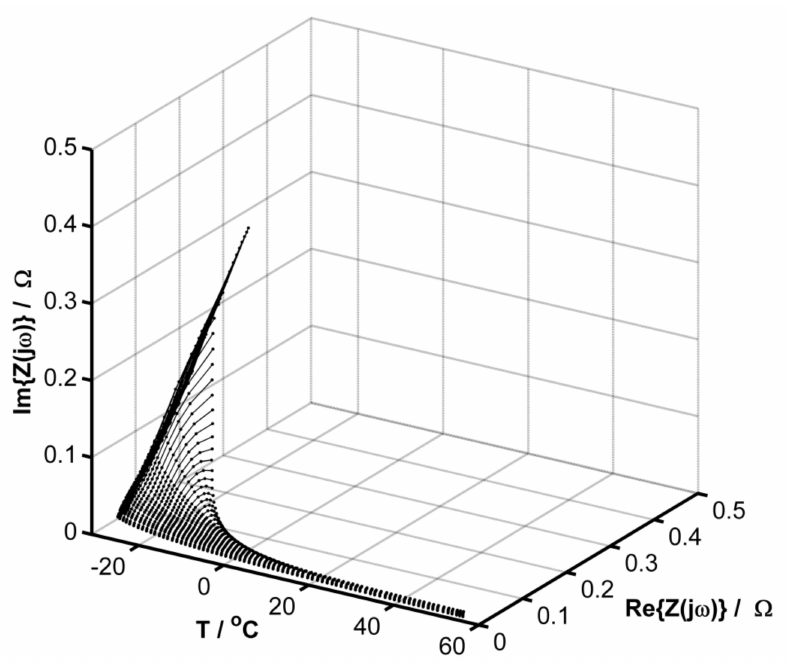
Figure 2. Impedance graph recorded for the tested LiC during dynamic temperature change in the range from − 30 to 60 degrees Celsius in the galvanostatic mode for SoC = 50% (3.0 V).